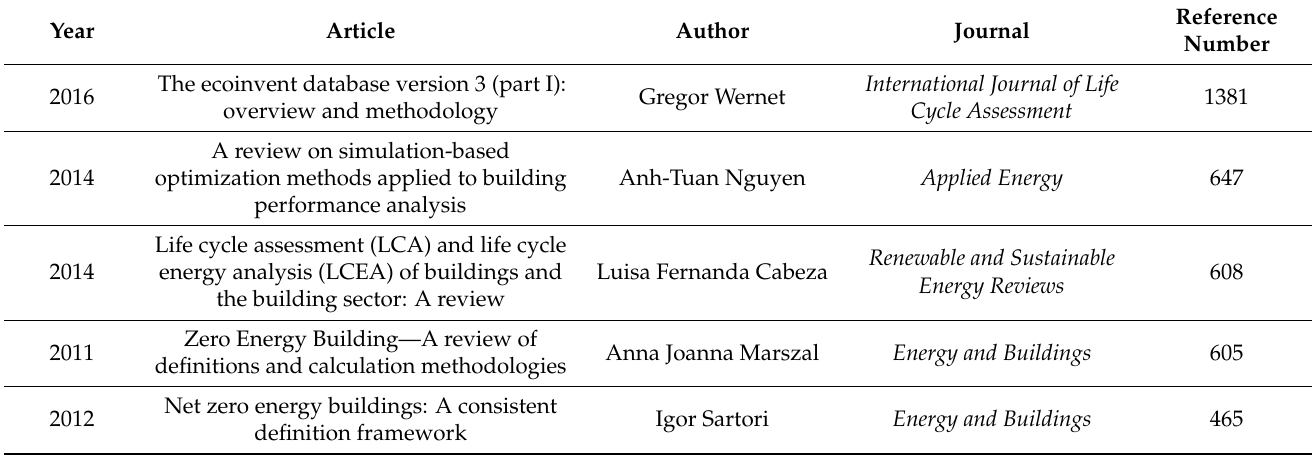
Table 8. Top ten cited articles from 2000 to